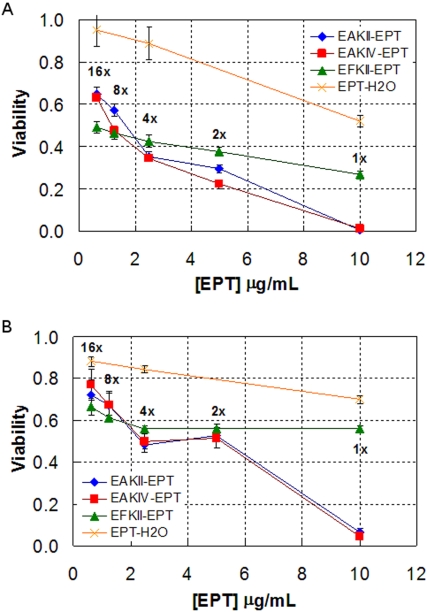
Cellular toxicity of the complexes formulated with the three peptides at a peptide concentration of 0.5 mg/mL and their serial dilutions in water for A549 cells (a) and MCF-7 cells (b).EPT: ellipticine.